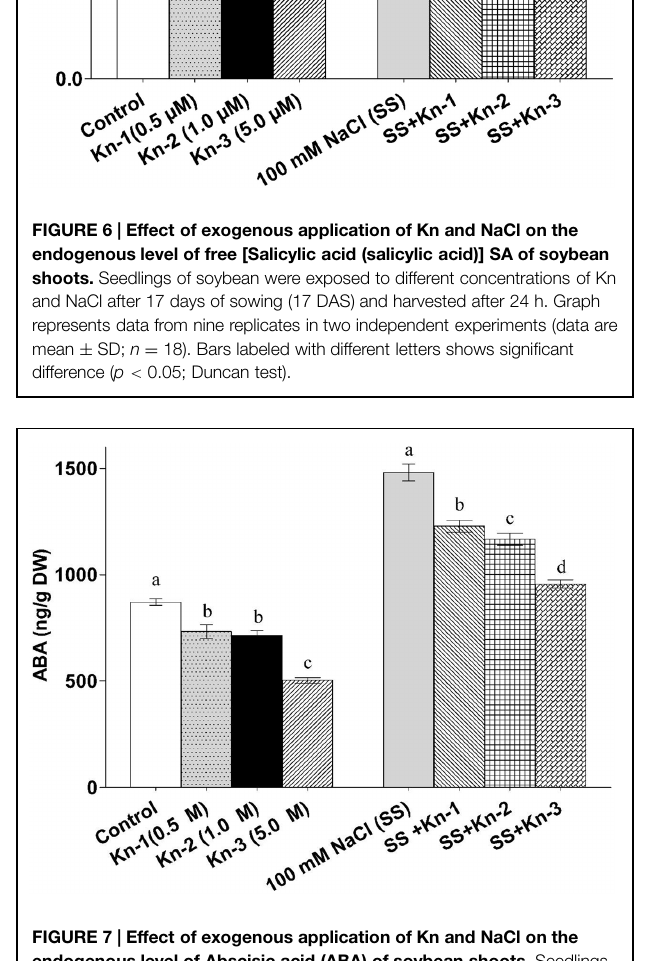
FIGURE 7 | Effect of exogenous application of Kn and NaCl on the endogenous level of Abscisic acid (ABA) of soybean shoots. Seedlings of soybean were exposed to different concentrations of Kn and NaCl after 17 days of sowing (17 DAS) and harvested after 24 h. Graph represents data from nine replicates in two independent experiments (data are mean ± SD; n = 18). Bars labeled with different letters shows significant difference ( p < 0.05; Duncan